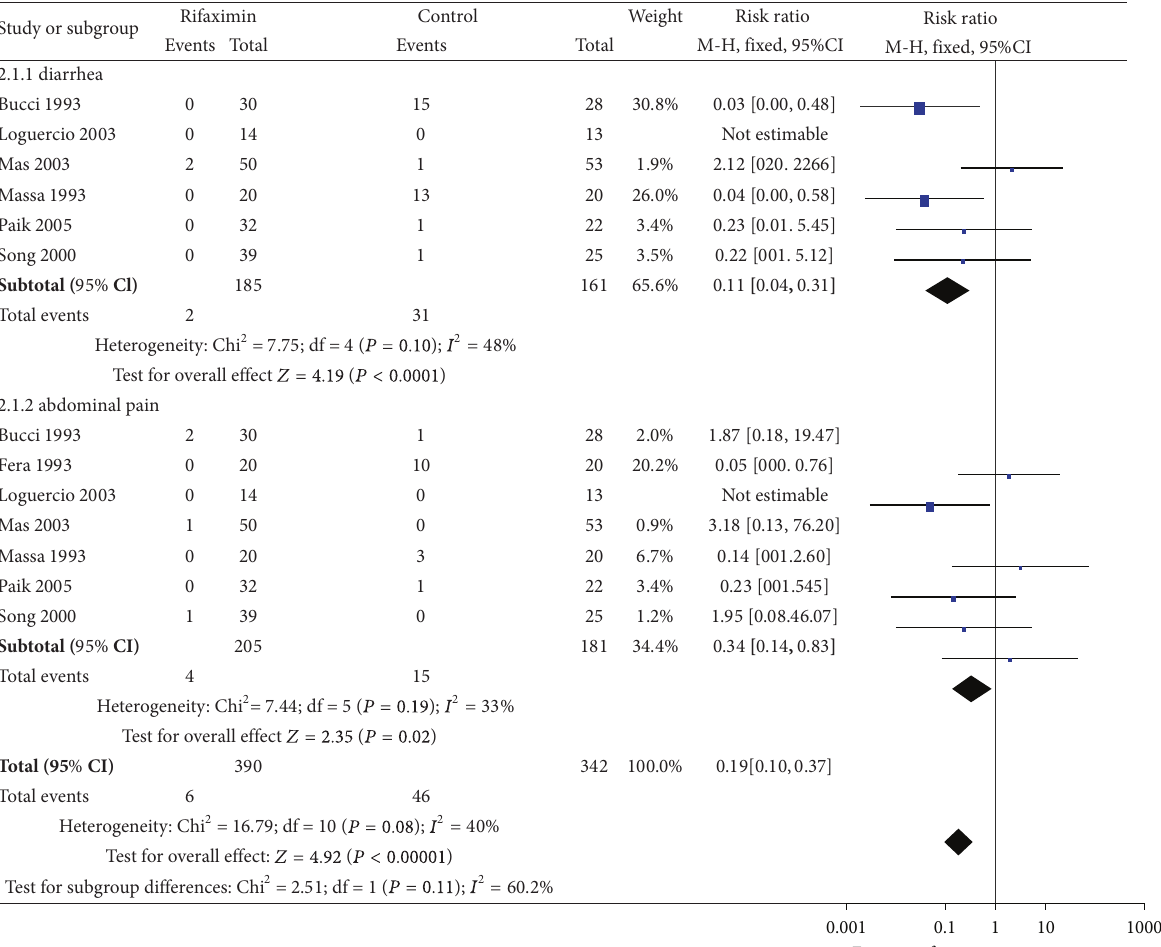
Figure 3: Adverse events of rifaximin versusnonabsorbable disaccharides in thetreatment of hepatic encephalopathy. M-H:Mantel